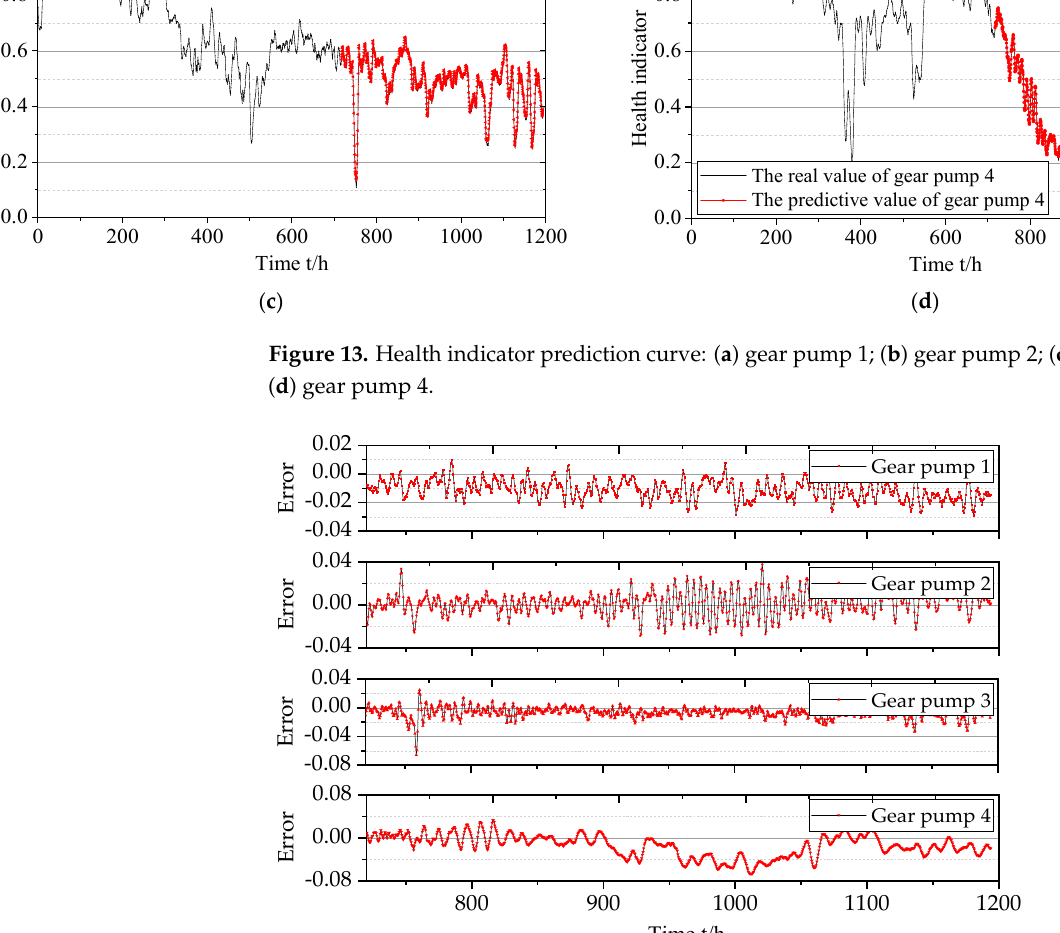
4321 Figure 15. Box diagram of health indicator prediction deviation of four gear pumps. According to Figure 14, it can be seen that the prediction error of the health indicator of the gear pump proposed in this paper was relatively small, and it had obvious ad- vantages over the important feature and principal component. According to the test pro- cess, it can be seen that the equipment was in the first stage of step pressure at 0–310 h, in the second stage of step pressure at 310–733 h, in the third stage of step pressure at 733– 1028 h, and in the fourth stage of step pressure at 1028–1200 h. The health states of the